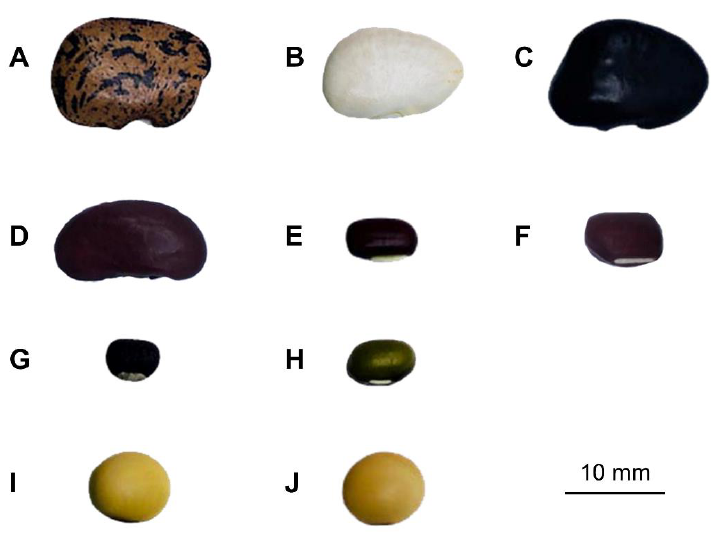
Figure 1. Illustration of bean seeds: Phaseolus lunatus L. cultivars ( A ) ‘ 38 ’ , ( B ) ‘ 47 ’ , and ( C ) ‘ 59 ’ ; ( D ) Phaseolus vulgaris L. cultivar ‘ 112 ’ ; ( E ) Vigna umbellata (Thunb.) Ohwi and H.Ohashi cultivar ‘ 107 ’ ; ( F ) Vigna angularis (Wild.) Ohwi and Ohashi cultivar ‘ 108 ’ ; ( G ) Vigna mungo (L.) Hepper cultivar ‘ CN4 ’ ; ( H ) Vigna radiata (L.) Wilczek cultivar ‘ CN84-1 ’ ; and Glycine max (L.) Merrill cultivars ( I ) ‘ SJ5 ’ and ( J ) ‘ CM60 ’ . Table 1. The scientific names, English common names, local Thai names, cultivars, and voucher specimens (Bangkok Herbarium (BK) numbers) of bean